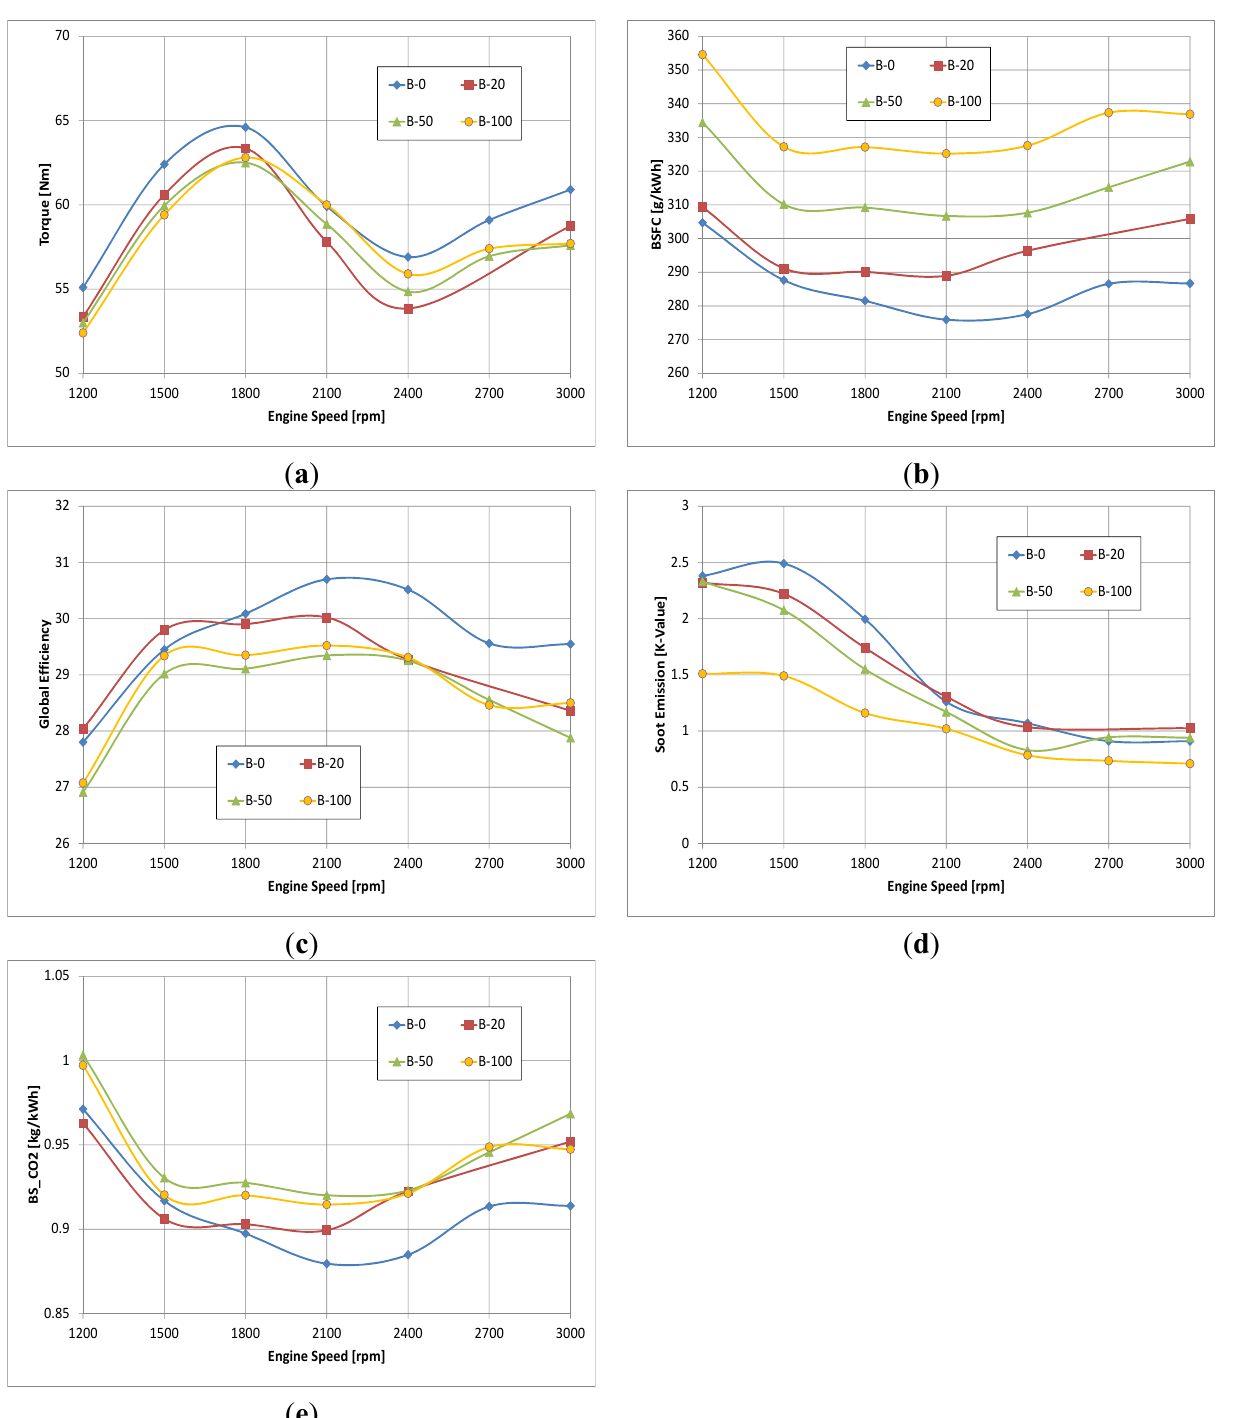
Figure 2. Engine performance and emission as a function of rotational speed ( a ) torque; ( b ) Brake Specific Fuel Consumption; ( c ) global efficiency; ( d ) soot emissions; ( e ) CO 2 specific